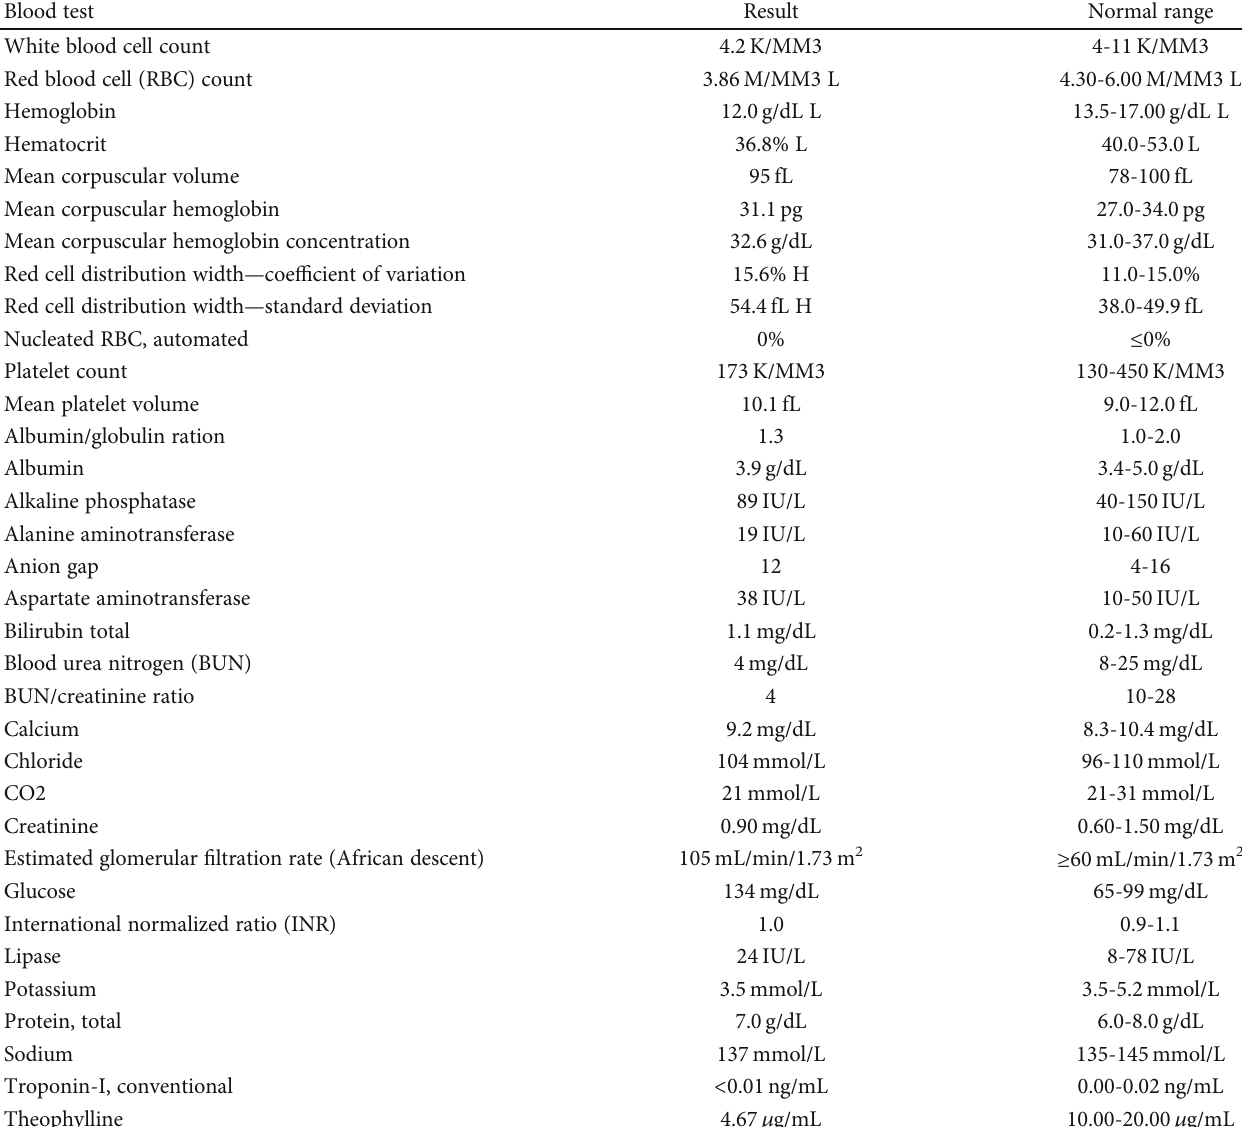
Table 1: Complete blood count, comprehensive metabolic panel, troponin, and theophylline blood test